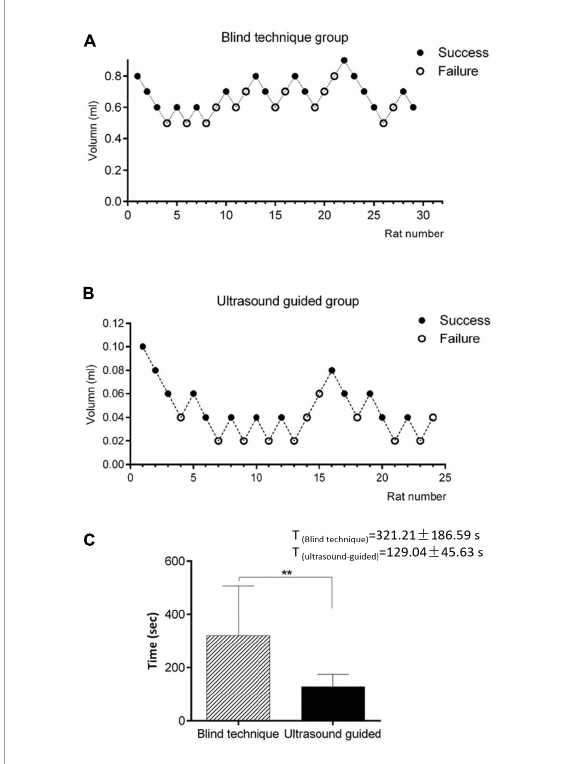
FIGURE4 (A) Minimum effective volume for SGB in the blind technique group. The minimum effective volume for SGB in the ultrasound-guided group was 0.040 ml, the 95% CI was 0.026–0.052 ml. (B) Minimum effective volume for SGB in the ultrasound-guided group. The minimally effective volume for SGB in the blind technique group was 0.639 ml, and the 95% CI was 0.490–0.733 ml. (C) Comparison of the average operative duration between the two groups. Compared with blind technique, ** P < 0.001. The average operative duration of ultrasound-guided SGB was significantly shorter than that of